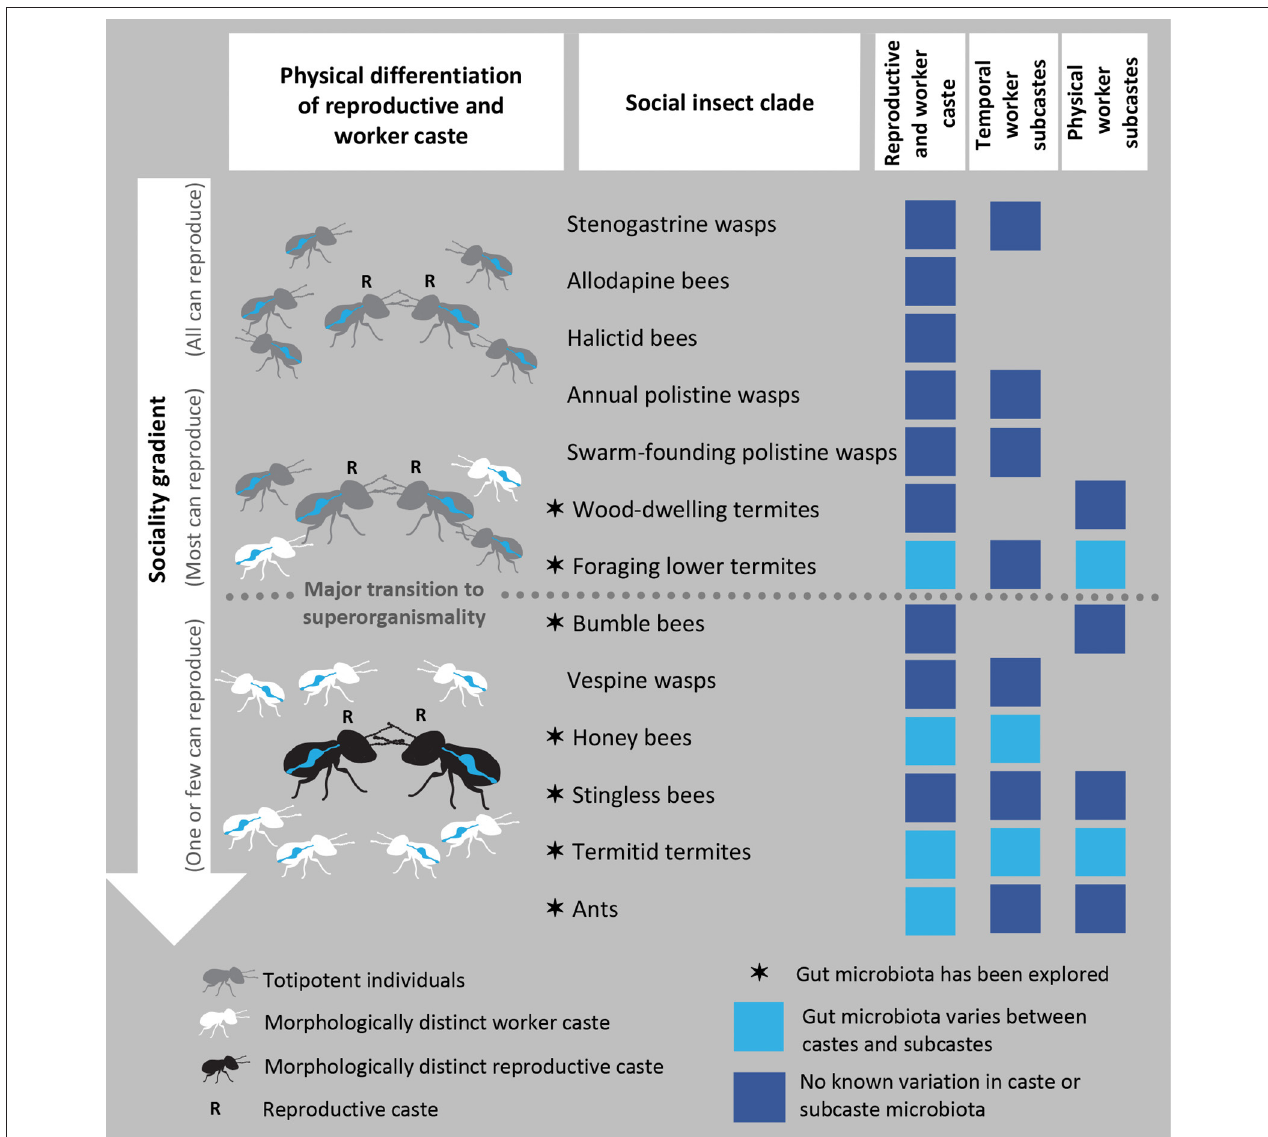
FIGURE 1 | The sociality gradient and gut microbial symbionts of social insects. The sociality gradient is illustrated by the greyscale changes in the insects, indicative of reductions in individual reproductive plasticity. The gradient begins with colonies where totipotent workers help reproductives through adulthood, to which subsocial family life is a critical evolutionary precursor and culminates in superorganismal colonies with morphologically distinct castes. The position of clades along the gradient is adapted from Boomsma and Gawne (2018). Clades for which the gut microbiota has been explored are marked with a star, while evidence or lack thereof on distinct (sub)caste microbiomes is represented by light and dark blue squares, respectively. The first column of boxes illustrates that all clades divide reproductive labor between the reproductive and worker caste. The second and third columns signify if members of the clade have specialized division of non-reproductive labor among temporal and physical worker subcastes (temporal: bees, Seeley, 1982; Wille, 1983; termites, Watson and Sewell, 1985; ants, Hölldobler and Wilson, 1990; physical: bees, Goulson et al., 2002; Spaethe and Weidenmüller, 2002; Evans, 2006; wasps, Jandt and Toth, 2015; Li et al., 2015; Du et al., 2017; Grüter et al., 2017; termites, Korb and Thorne,